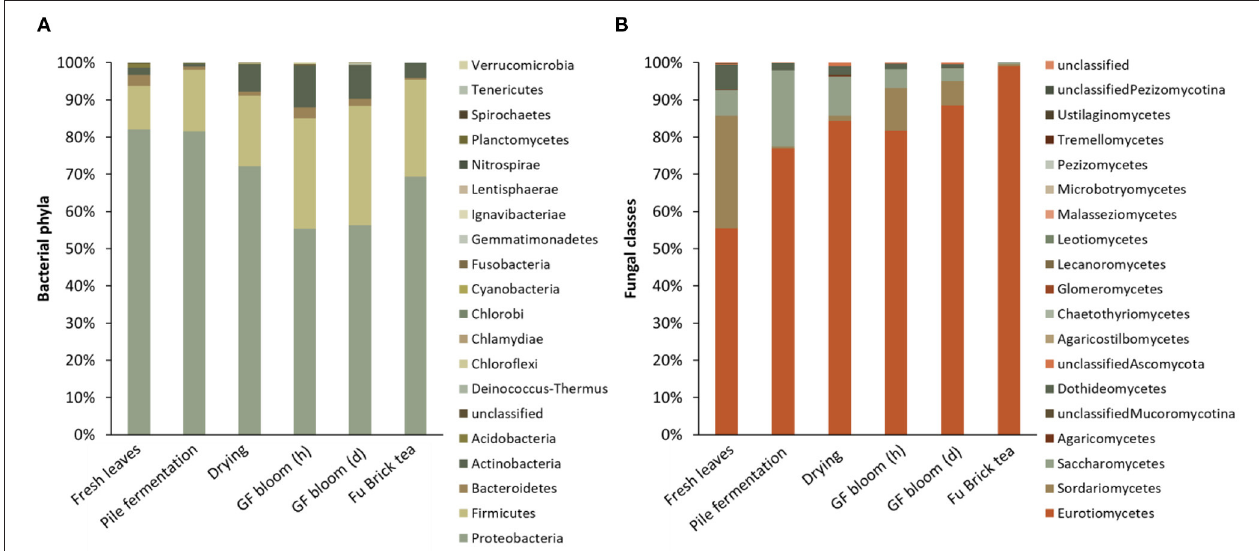
FIGURE 3 | The relative abundances of bacterial phyla (A) and fungal classes (B) in each examined stage of the Fu Brick manufacturing process. “GF bloom (h)” is the early stage golden flower bloom, and “GF bloom (d)” is the full golden flower